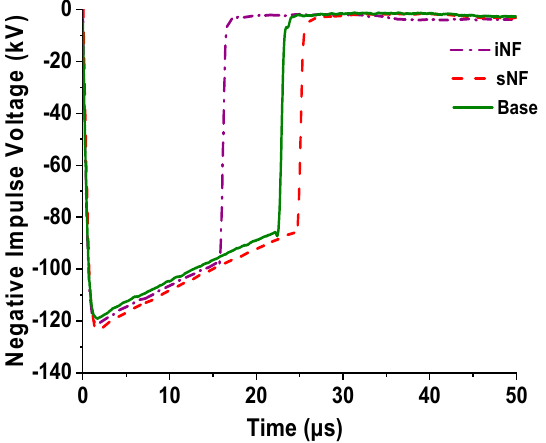
Figure 9. Oscillogram of the negative LI BDVs of the under-study samples at 50% breakdown probability level.